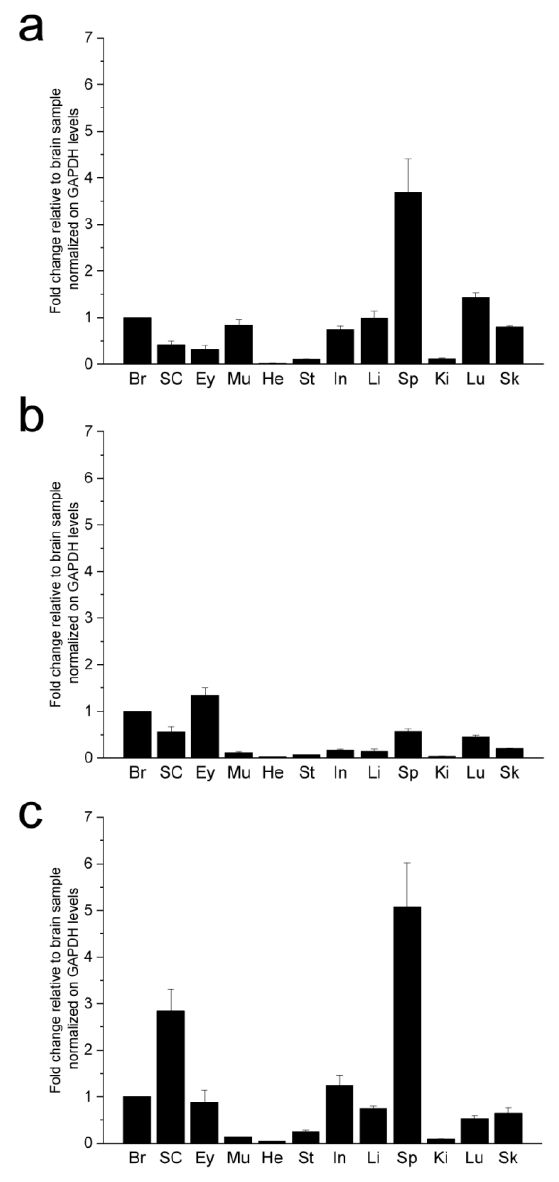
Figure 2. Syn gene expression in the major organs of adult Xenopus . qRT-PCR analysis of α - ( a ), β - ( b ) and γ - ( c ) syn gene expression in the main organs of adult Xenopus . Expression levels were normalized against GAPDH and expressed as fold change relative to brain sample. Br: brain, SC: spinal cord, E: eye, Mu: muscle, He: heart, St: stomach, In: intestine, Li: liver, Sp: spleen Ki: kidney, Lu: lung, Sk: skin.